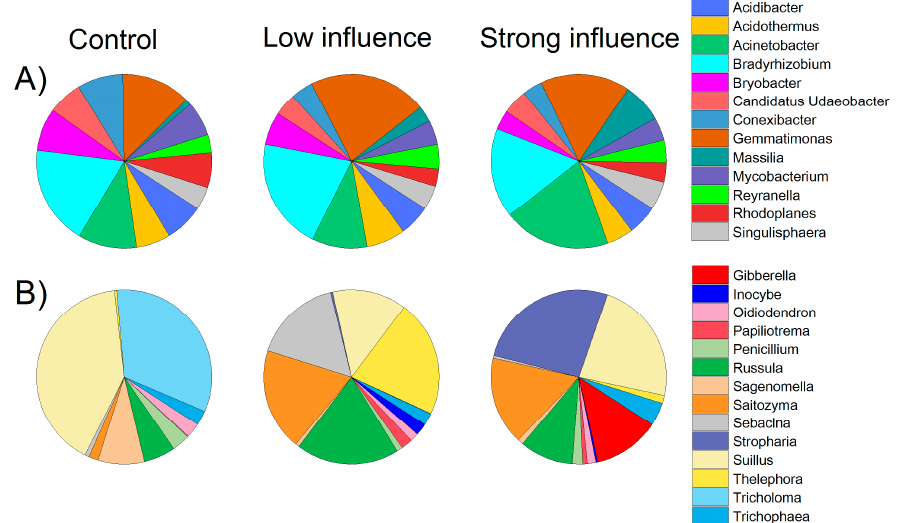
Figure 2. Abundant (>0.5% relative abundance) soil bacterial ( A ) and fungal ( B ) genera found in soils with low and strong influence of Stropharia rugosoannulata cultivation and control soils. Uncultured and unclassified/unidentified genera are not presented. Detailed information of the treatments is described in Table 1.